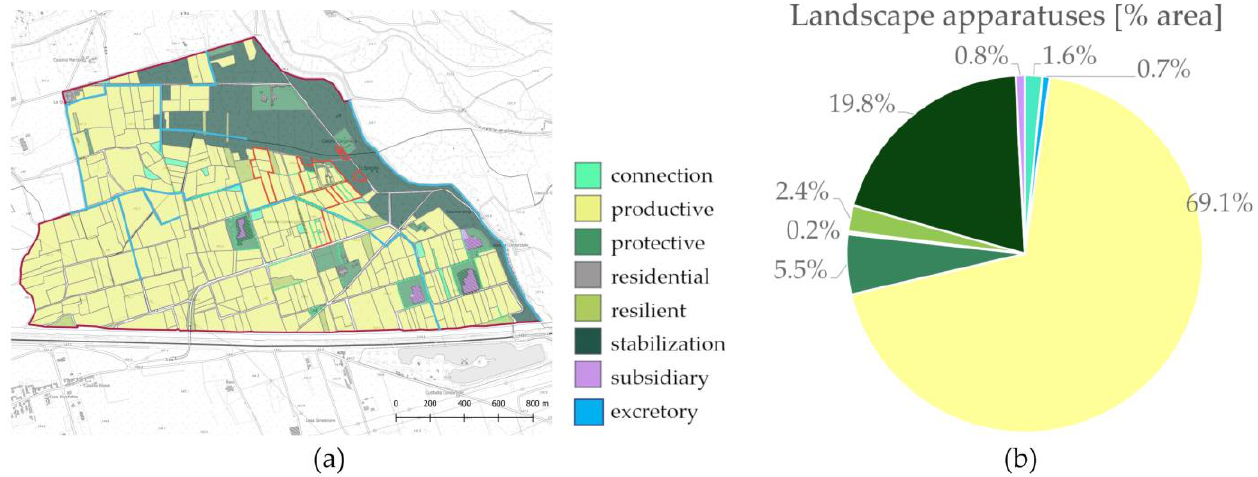
Figure 3. ( a ) Local-scale landscape apparatuses’ spatial configuration. ( b ) Local scale landscape apparatuses percentage distribution (area i /total area; with area i = total area of each landscape apparatus).